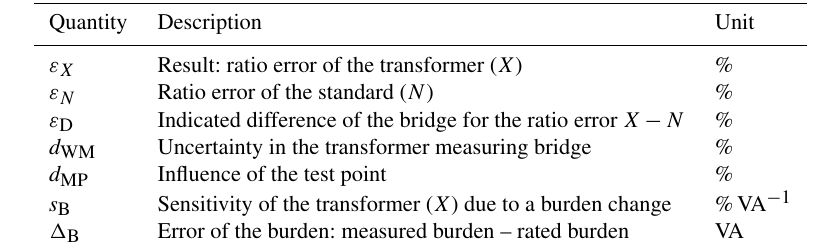
Table 1. Description of the symbols used.